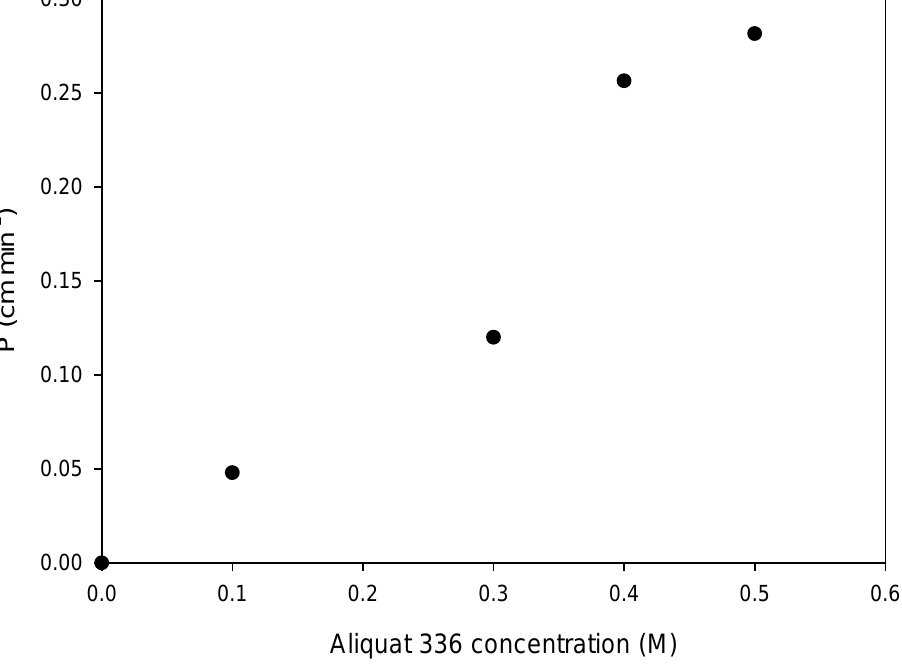
Figure 3. Effect of Aliquat 336 concentration in decaline on Cd permeability. Feed phase: 10 mg L − 1 Cd in 2 M NaCl.